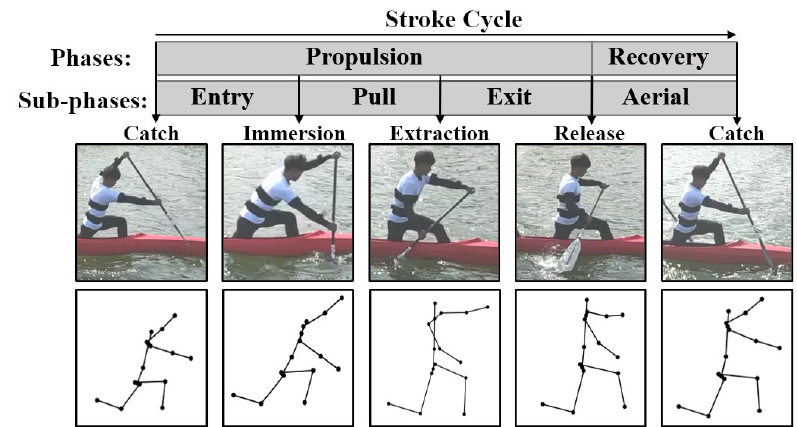
Figure 10. Phases definition of the canoeing stroke cycle (entry, pull, exit and aerial) separated by paddle positions (catch, immersion, extraction and